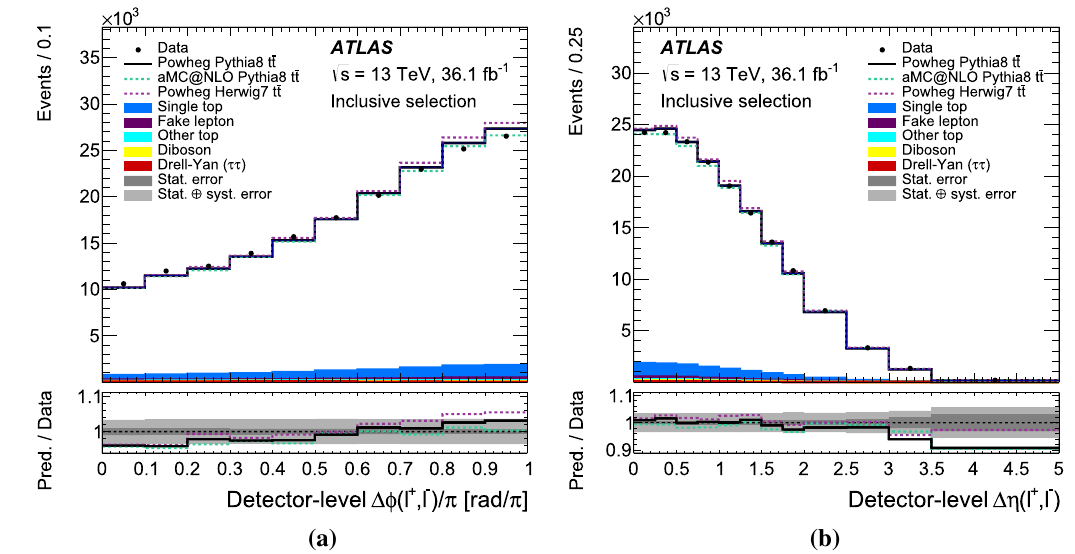
ing transverse momentum, background modelling, pile-up modelling and luminosity, but not PDF or signal t ¯ t modelling uncertainties. The observed distribution is compared to the sum of signal and background using three different t ¯ t signal models: Powheg + Pythia 8, Powheg + Herwig 7 and MadGraph5 _aMC@NLO + Pythia 8, and the ratio panel compares the summed prediction to data for the three models